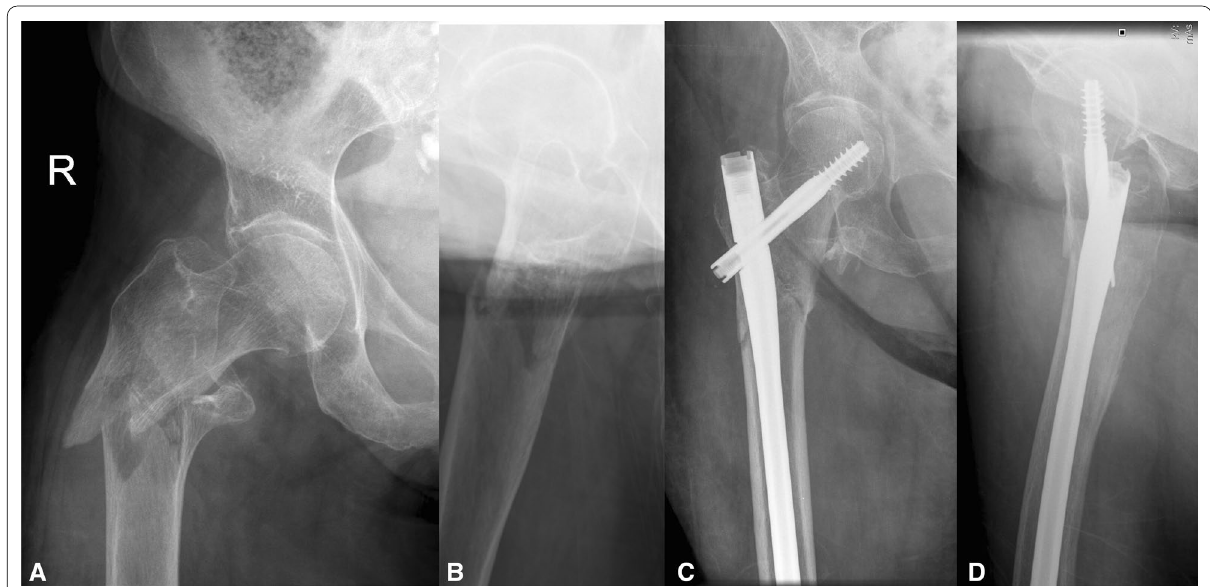
Fig. 1 Pre-operative AP ( A ) and lateral ( B ) radiographs and post-operative AP ( C ) and lateral ( D ) radiographs of a subtrochanteric fracture managed with a Gamma nail